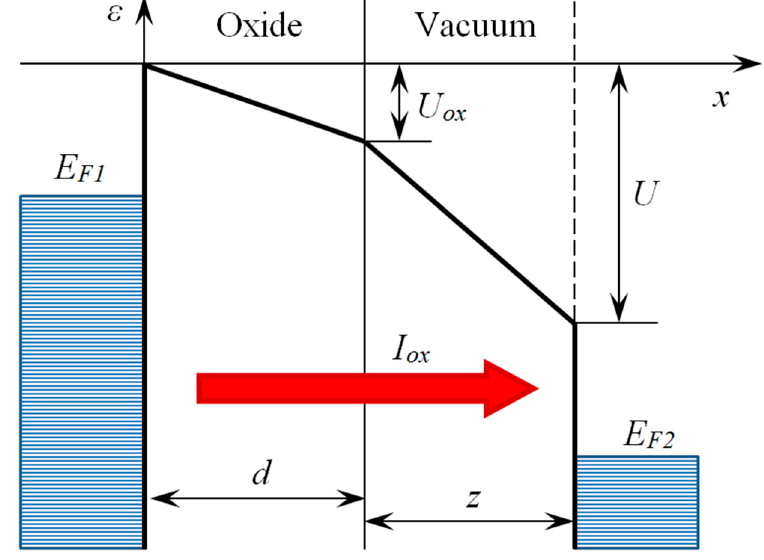
Figure 5. An energy diagram explaining the process of electron tunneling through an oxide layer of thickness d and a vacuum gap of width z depending on a bias voltage U .